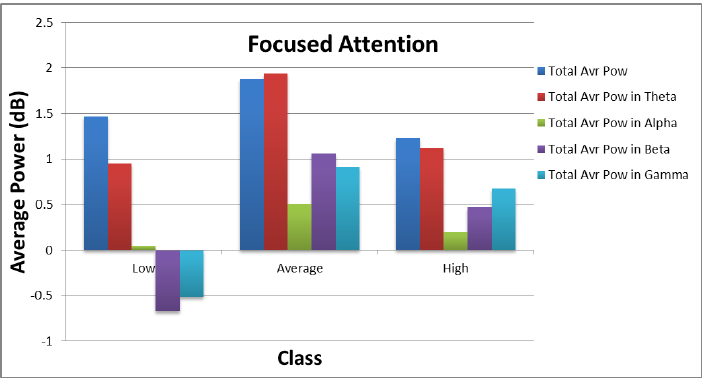
Figure 10. Distribution of average power values across different categories of focused attention.